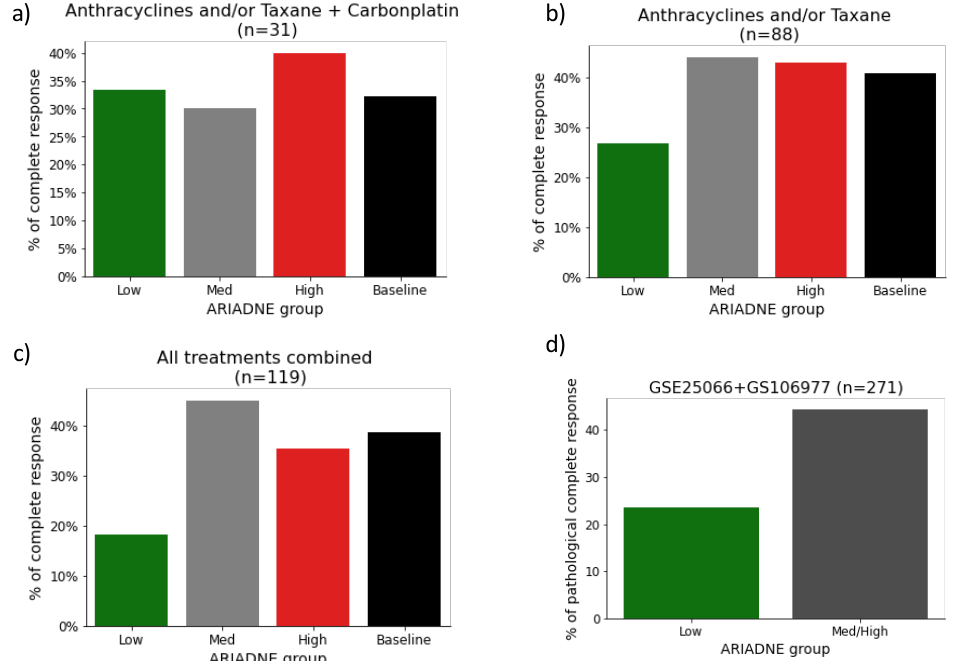
Figure 4. Response to neoadjuvant chemotherapy with and without carboplatin for different ARI- ADNE groups for dataset GSE106977: Percentage of patients with pathological complete response for the three different ARIADNE groups compared with the baseline provided by the entire population for ( a ) all treatment combined, ( b ) only treated with anthracycline and/or taxane, ( c ) treated with anthracycline and/or taxane plus carboplatin; ( d ) response to neoadjuvant chemotherapy, combining with patients from GSE106977 (excluding those treated with carboplatin) with those from GSE25066. A Fisher exact test on the two groups yielded p =